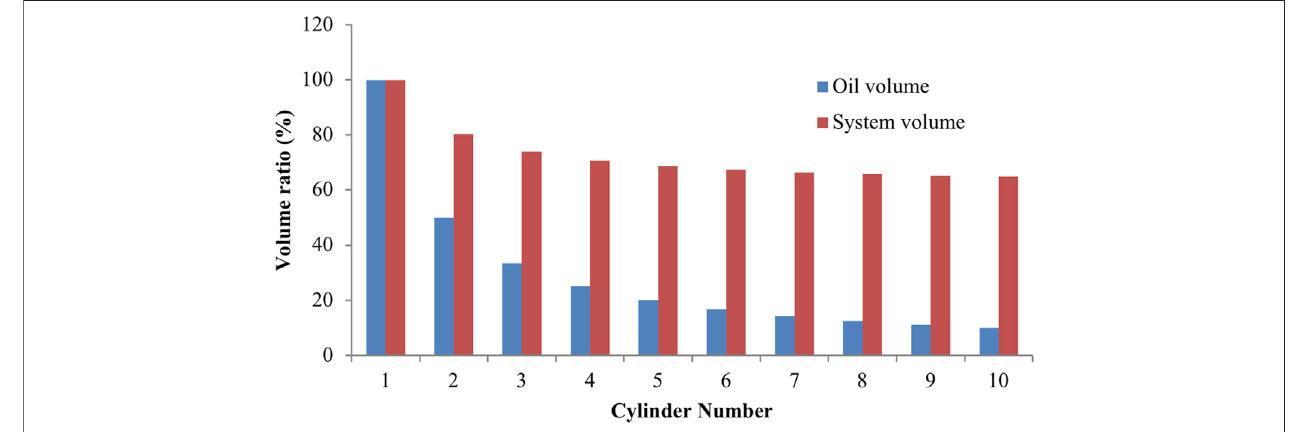
FIGURE 3 | Volume ratio of IHESS to HESS (Tong, et al.,